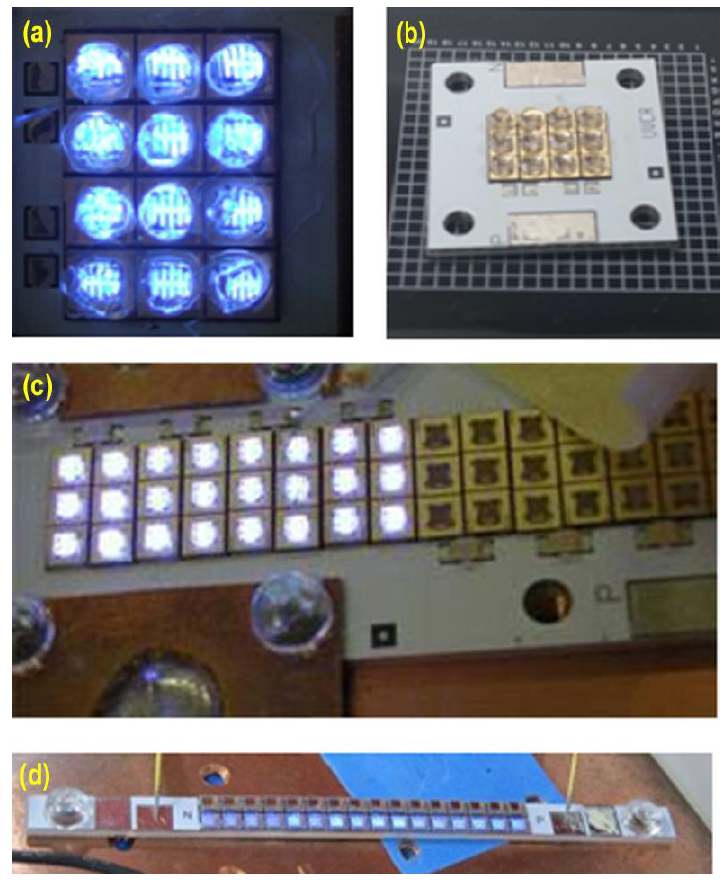
Figure 21. ( a – d ) Photographs of 285 nm irradiation modules. ( a ) Lighting; and ( b ) non-lighting 3 × 4 array module with encapsulation, respectively. The output power is 472 mW at the injected current of 200 mA for each die. The total AlN submount area of the 12 diode array is 10.0 × 13.2 mm 2 . Modules without encapsulation: ( c ) photograph of 3 × 16 array module with dies having 3.4 mm pitch; and ( d ) LED dies with denser layout of 2.5 mm pitch. The die size is 1300 × 1300 µm 2 . (( a , b ) are reused from